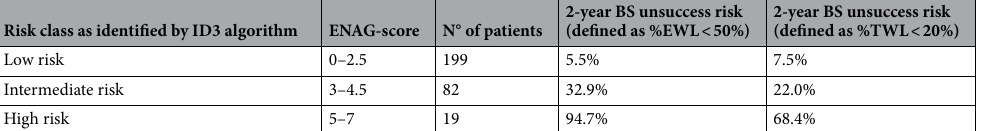
Table 5. Early post-surgical estimation of unsuccessful weight loss at 2-years from BS according to ENAG- score risk classes. BS bariatric surgery, EWL excess weight loss, ID3 Iterative Dichotomiser 3, TWL total weight